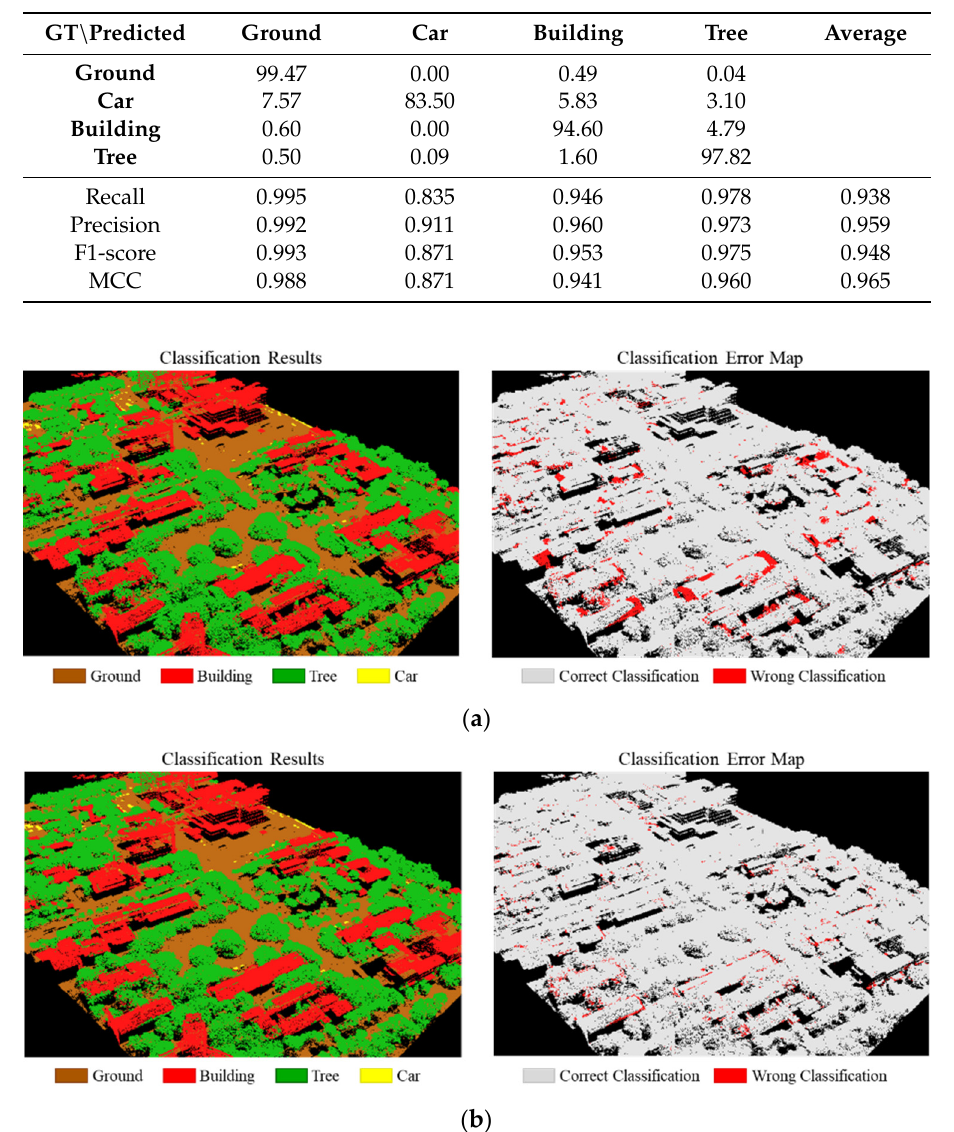
Figure 14. Comparison of classification results on ALS point clouds: ( a ) Classification results and error map of ALS_PointNet_1; ( b ) Classification results and error map of ALS_PointNet_4.